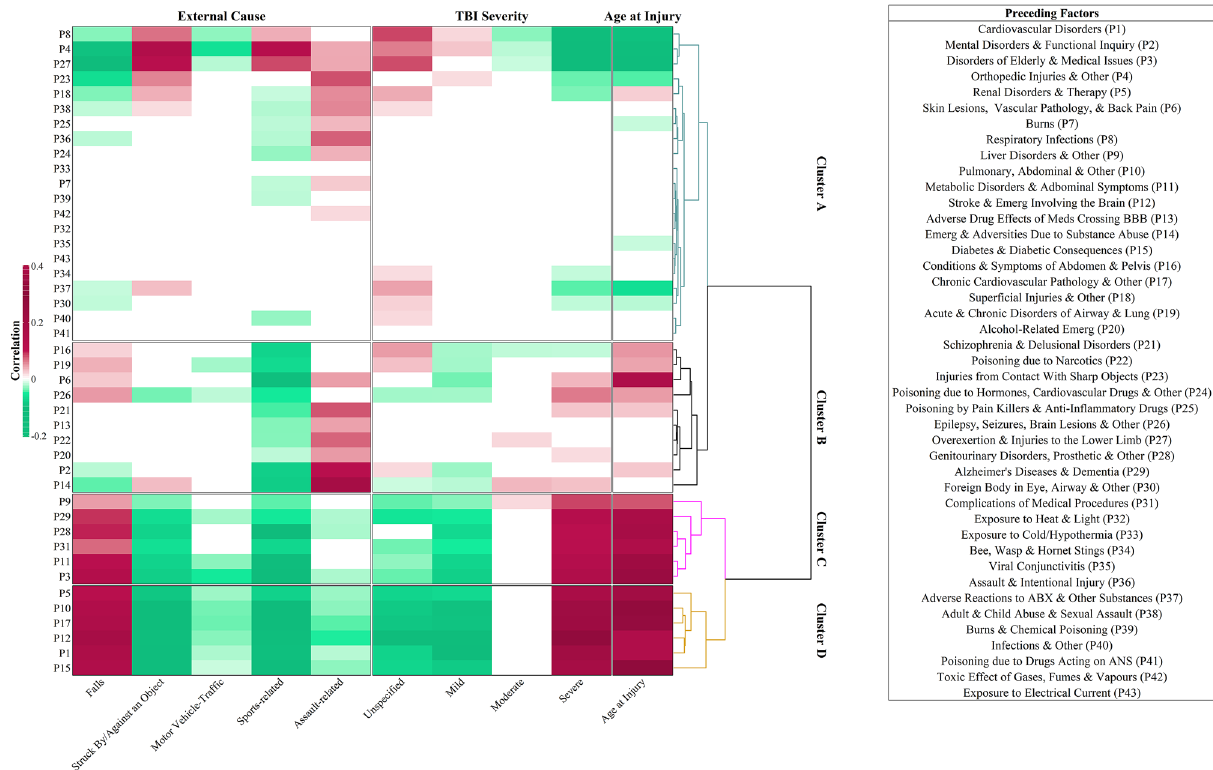
Figure 4. Cluster analysis and heatmap across 43 factors preceding TBI (y-axis) and mechanism, context of injury and TBI severity (x-axis). On the right y-axis, sample-based clusters are observed. Annotations are presented as guidelines and are not definitive. Only factors that were internally validated in the testing and validation datasets are represented. In the heatmap, each colour represents a set of binned ranks in the heatmap, with green colours representing negative correlations and magenta colours representing positive correlations, adjusted for FDR. White fields represent non-significant correlations after adjustment for